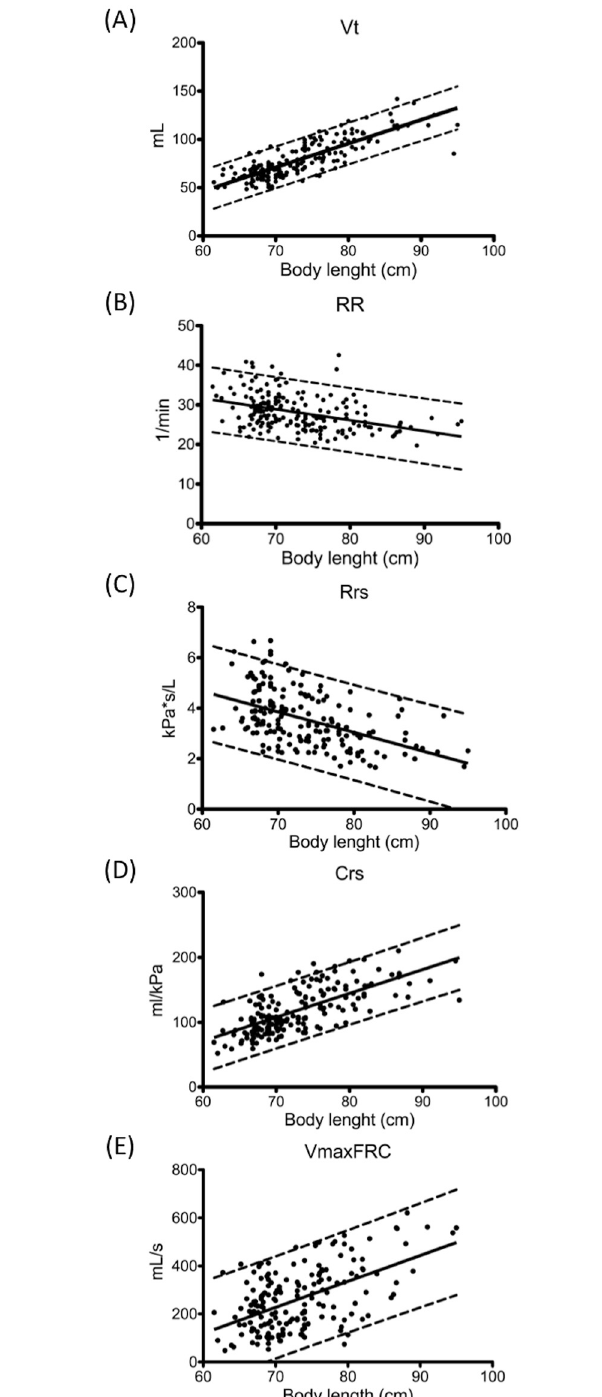
Fig 2. Regression curves of various parameters. Regression curves (means and 95% confidence bands) of various parameters including (A) tidal volume (Vt), (B) respiratory rate (RR), (C) resistance (Rrs), (D) compliance (Crs), and (E) maximal flow at functional residual capacity (VmaxFRC), plotted against crown- heel length at the time of the test.